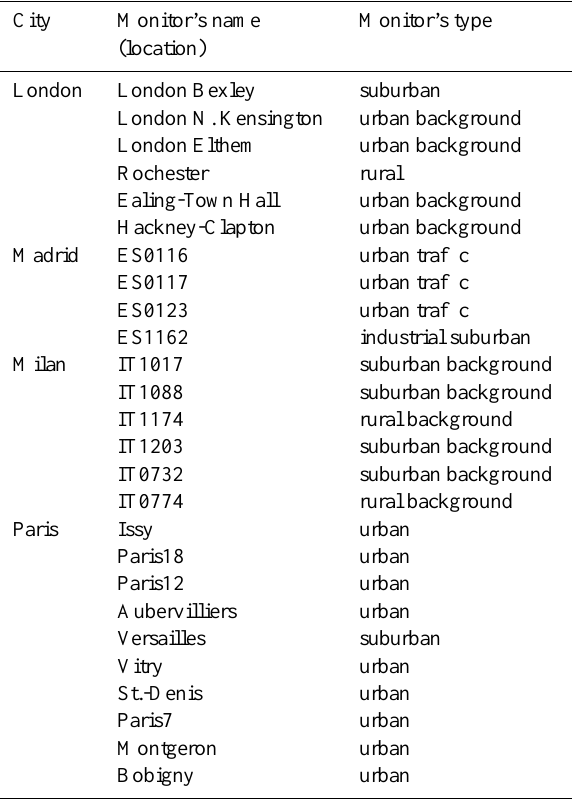
Table 1. The air quality monitors selected for this study.